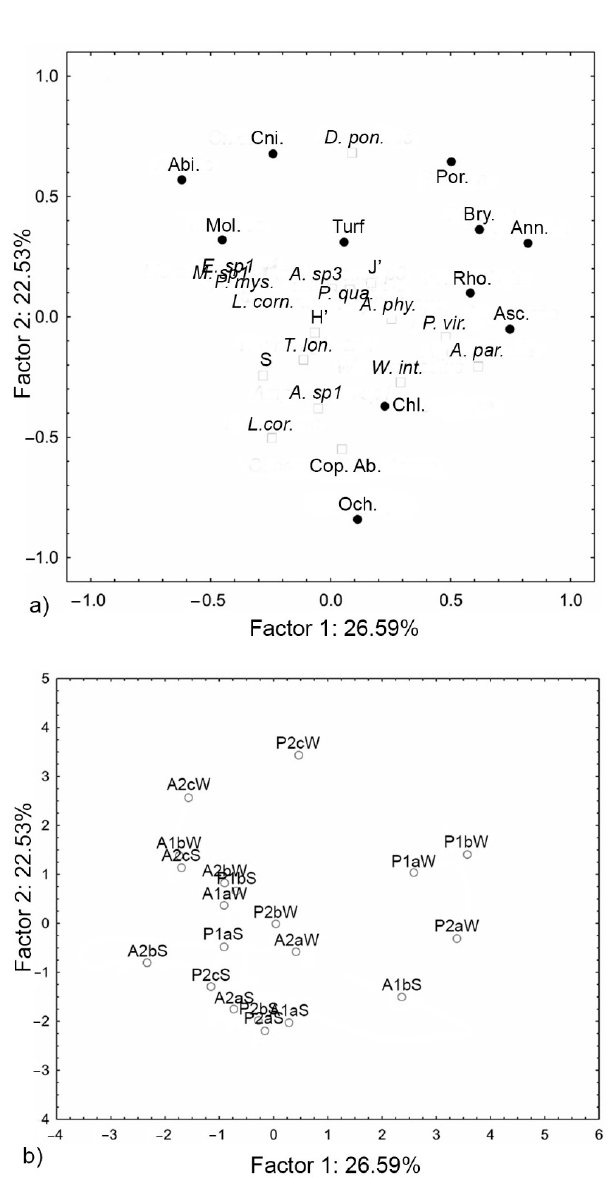
Figure 4. ( a ) Principal component analysis (PCA) of macrobenthic percentage coverage used as primary variables without contributing to the overall variance explained by the PCA. The copepod species and faunal parameters (relative abundances and indices) were projected on the factor plane as supplementary variables, with no contribution to the results of the analysis; ( b ) Plot of the cases obtained by the projection of the active variables on the factor plane. All the abbreviations of the taxa are listed hereafter: Longipedia coronata : L. cor.; Porcellidium viride : P. vir.; Thalestris cfr longimana :